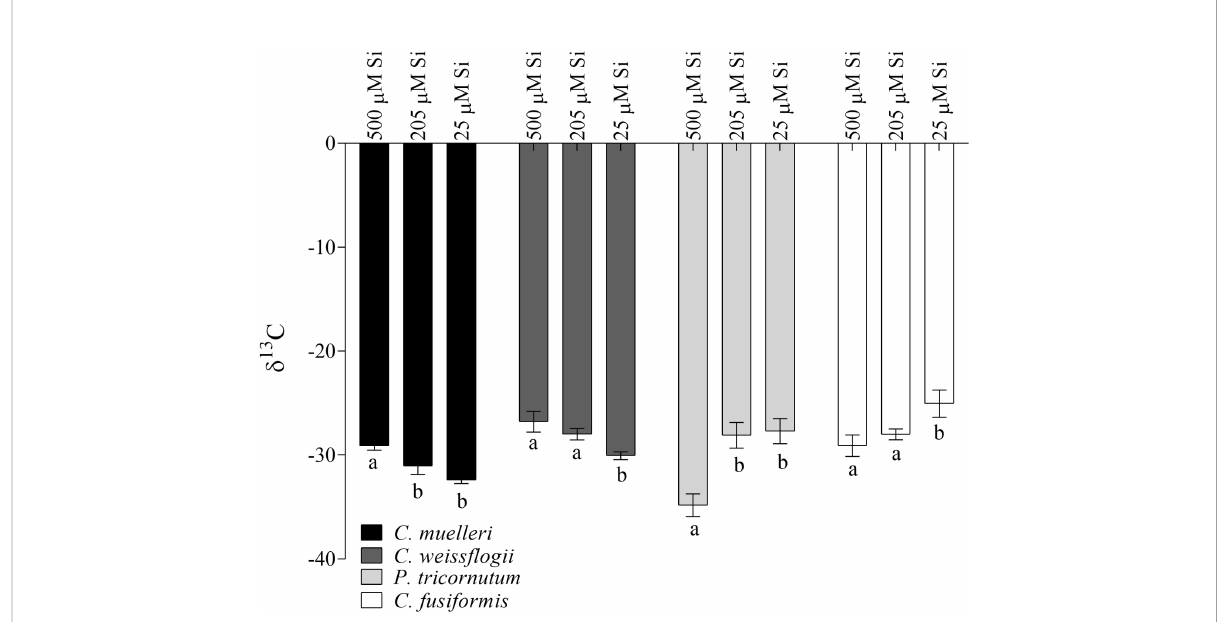
FIGURE 2 d 13 C values in the four diatoms acclimated to different paleoenvironments. Data are means of three biological replicas. Error bars show SD. Different letters represent signi fi cant differences among conditions in the same species (p< 0.05, one-way ANOVA followed by Tukey ’ s post hoc test, results in Table S3).